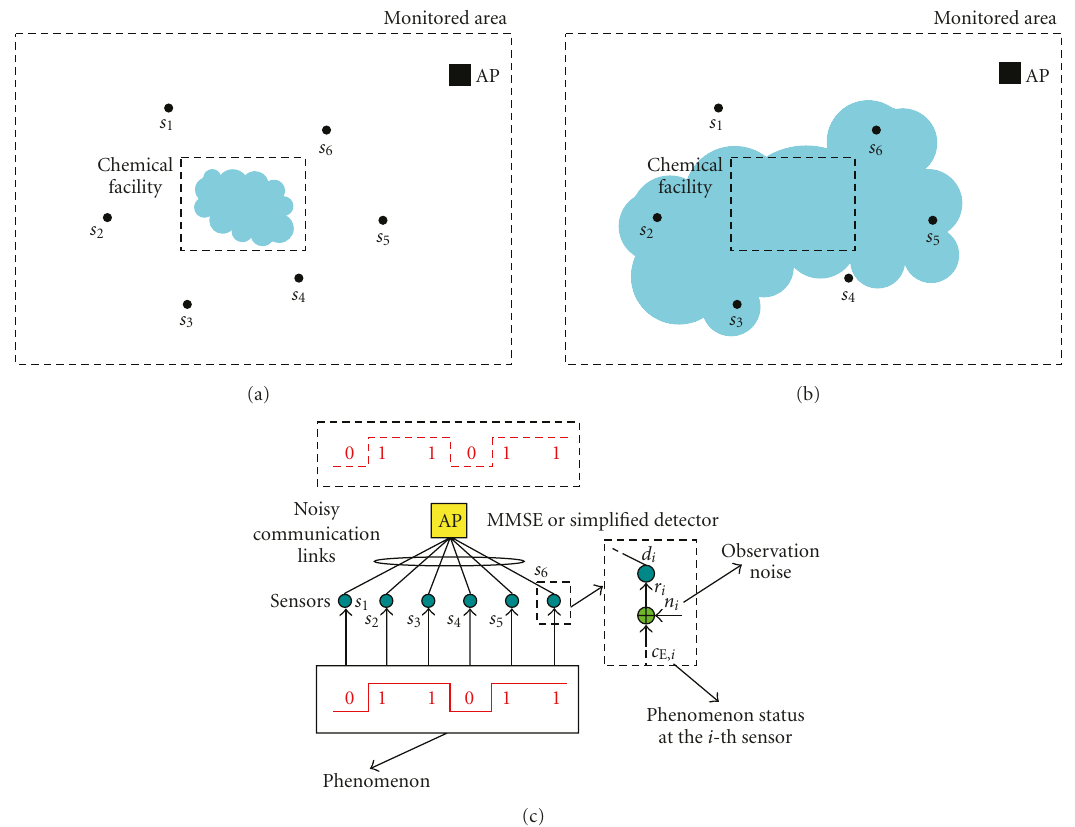
Figure 1: Illustrative scenario of interest: (a) a chemical facility processing dangerous gas; (b) scenario after gas leakage; (c) logical representation of the sensor